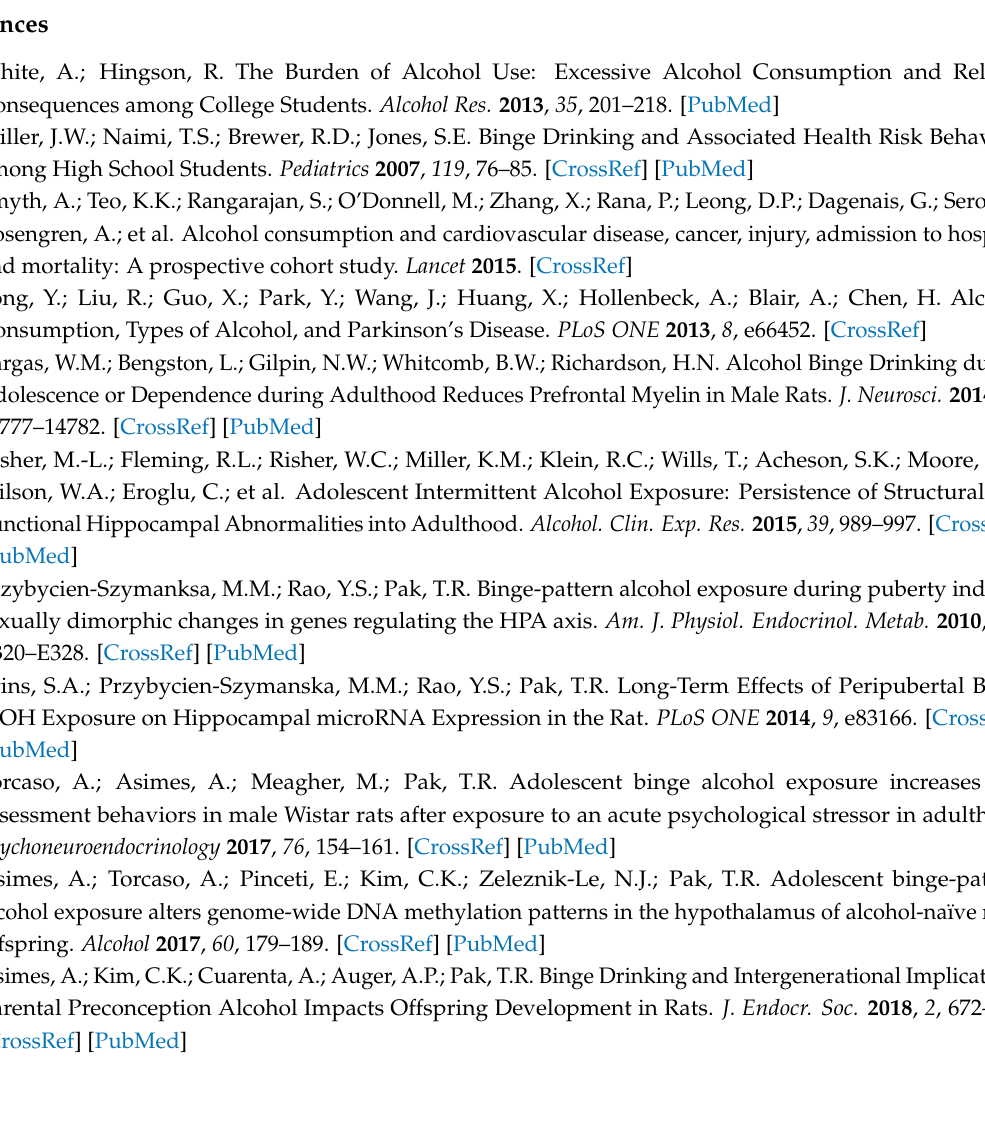
Table S1: miR array gene list, Table S2: mRNA array gene list, Table S3: qPCR primers, Table S4: